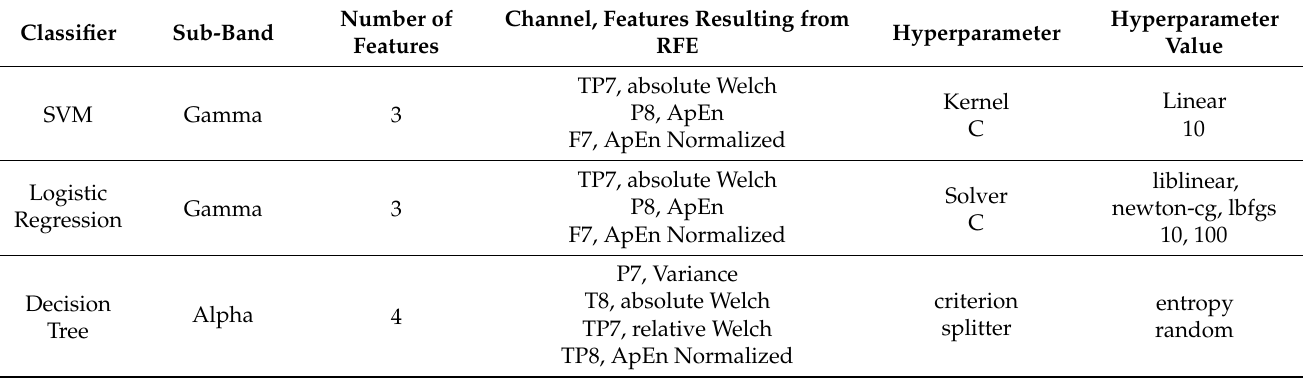
Table 5. Features resulting from RFE and model hyperparameter values for the best performances of ML algorithms.